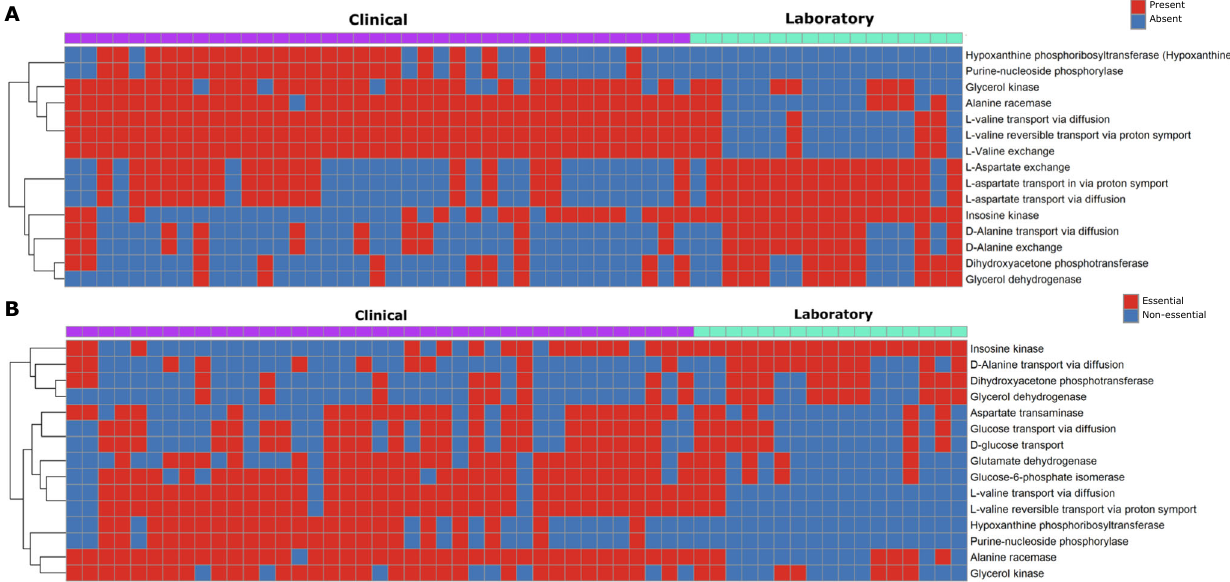
Fig. 3 Environmental valine is differentially essential in clinical isolate context-speci fi c models of K. pneumoniae . A Reaction topology differentially present between the context-speci fi c model groups. B Differential reaction essentiality between isolate model groups, essentiality was determined through single reaction knockout screen with a cutoff of 1% of the biomass fl ux. Inclusion in fi nal analysis was determined by cross reference against uncontextualized GENRE and a within-group shared threshold of >55% of models possessing a given feature. Color within the fi gure area indicates essentiality/presence (red) and non-essentiality/absence (blue), and color on the top margin denotes strain-type of origin for the associated transcriptome with clinical isolate (purple) or laboratory strain